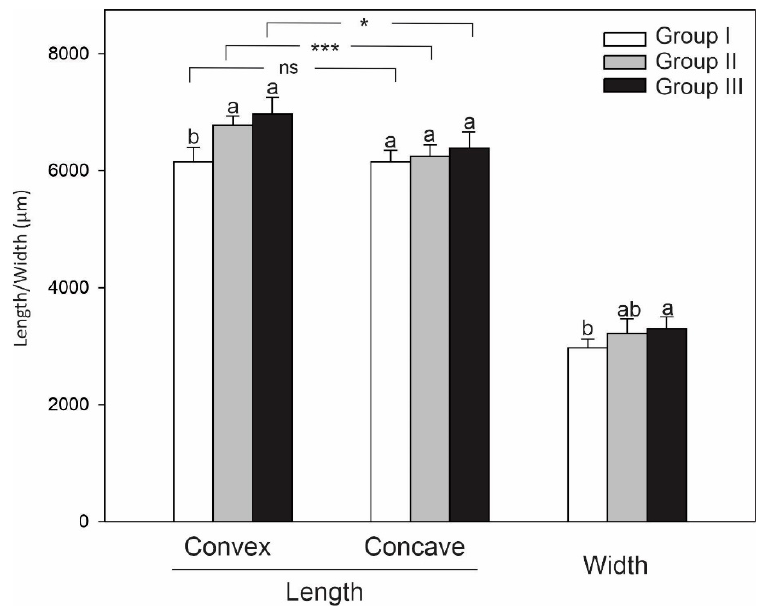
Figure 1. Mean (±SD) morphometric parameters of vertebrae in three groups of treatment: group I, beginning of experiment; group II, induced scoliosis; group III, after correction. Values followed by different letters are significantly different according to Tukey’s test ( p < 0.05); * and *** indicate significant differences between convex and concave length within the same group at the 0.05 and 0.001 levels of Student’s t -test; ns, non-significant.